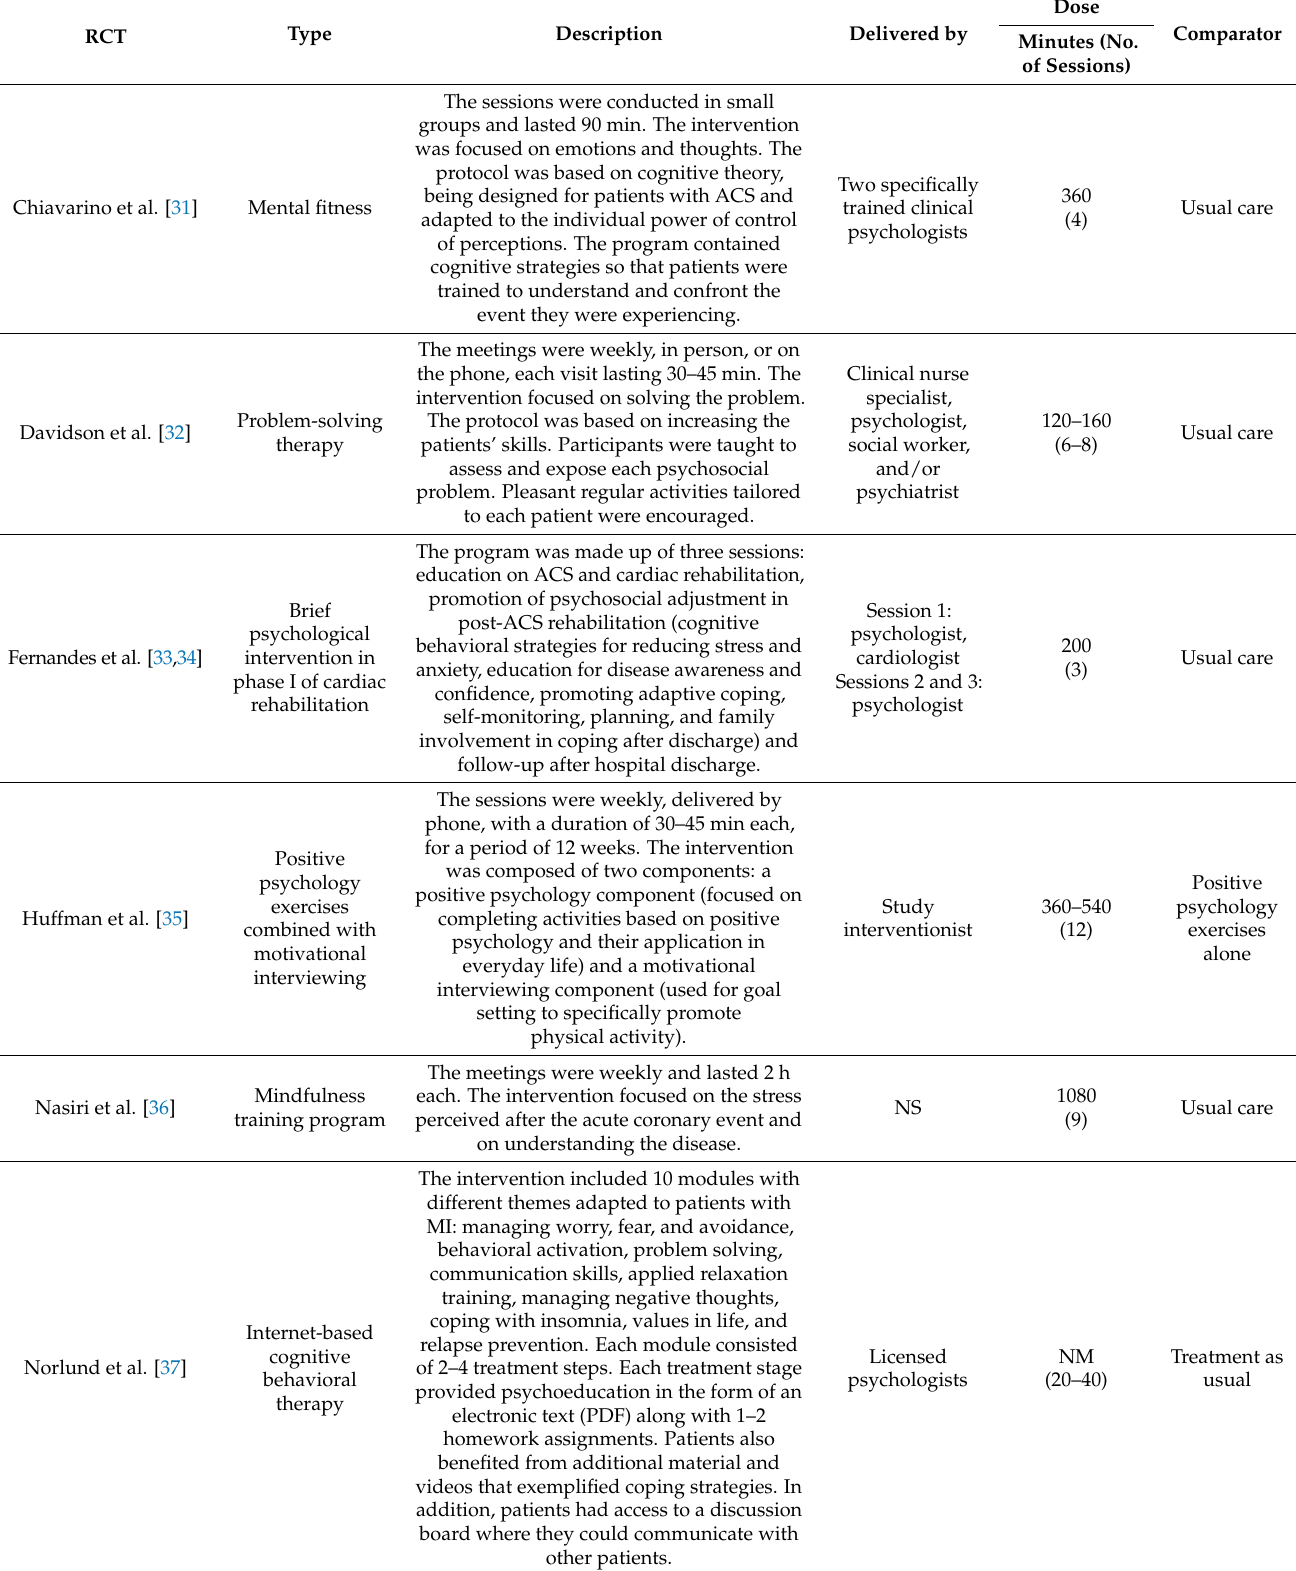
Table 2. The intervention details for each study (ordered by study